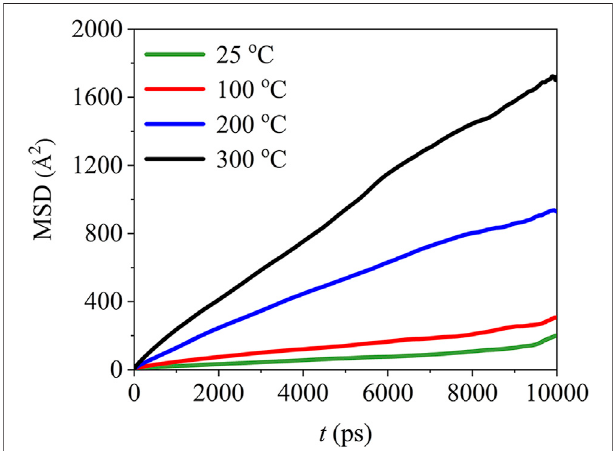
FIGURE14| MeansquaredisplacementofPTFEmoleculesinthe(110)/ PTFE interface system under different